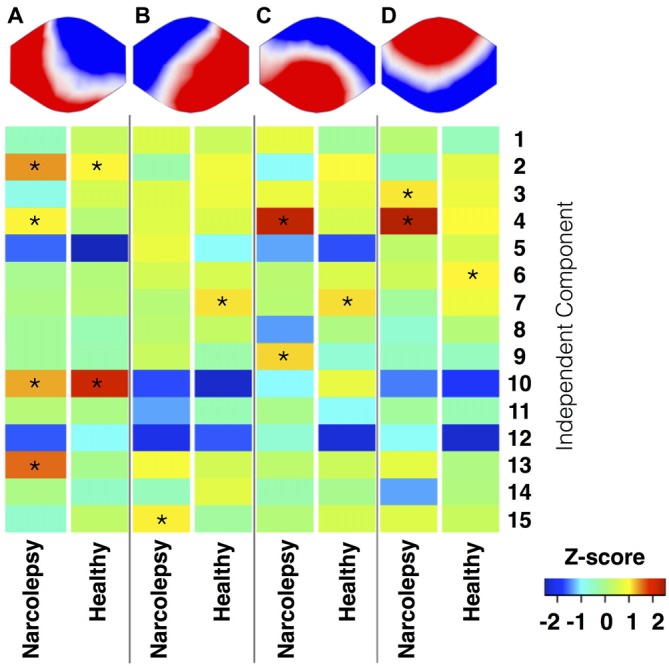
Temporal correlation of EEG microstates and functional magnetic resonance imaging (fMRI) RSNs. This figure shows the results of the temporal sorting of the RSNs using the time courses of the four EEG microstates. Results are stratified in terms of microstate and study group, with results for the narcolepsy patients and controls displayed separately. The temporal sorting regression coefficients are displayed in terms of Z-scores. *Indicates a temporal correlation with a Z-score >1.